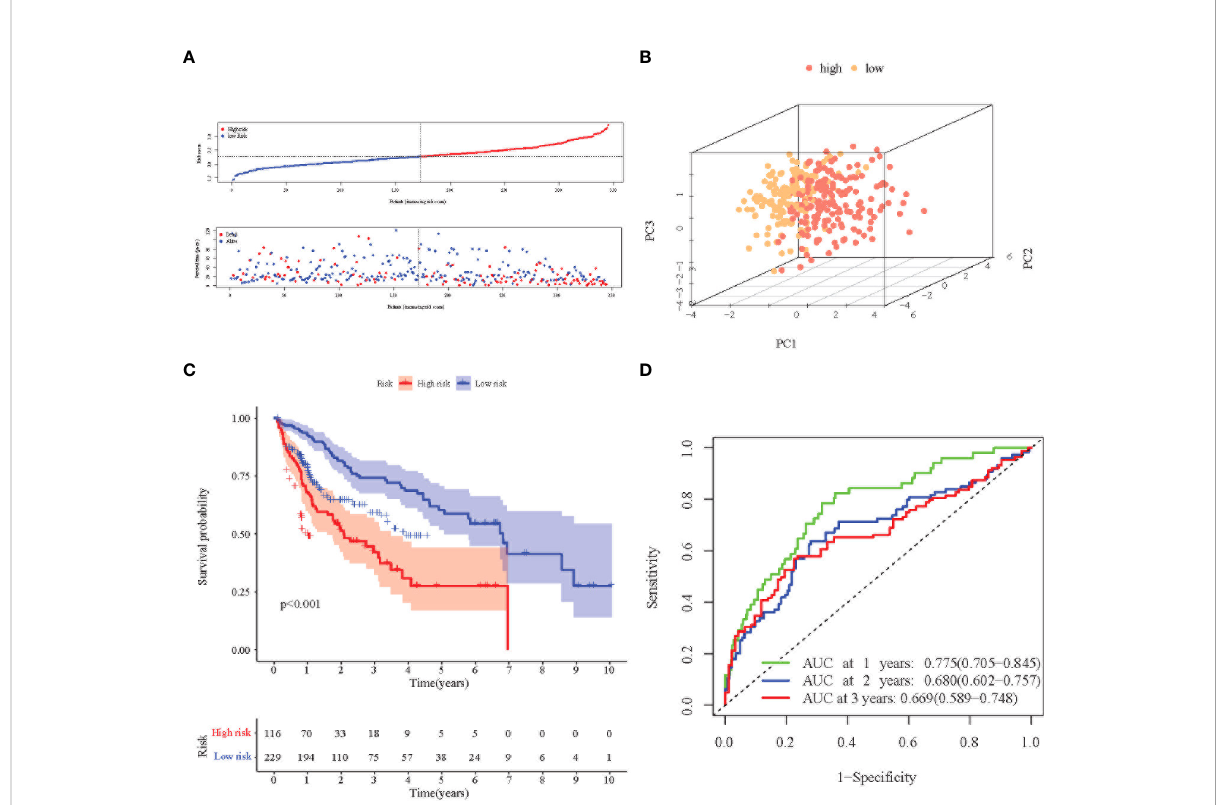
FIGURE 3 Prognostic analysis of the 8-gene signature in the TCGA cohort. (A) Distribution of risk score in high-risk and low-risk groups of the TCGA cohort; and distribution of overall survival in the TCGA cohort in different groups. (B) 3D-PCA analysis of the TCGA cohort. (C) Kaplan – Meier curve of the 8-gene signature in the TCGA cohort (P<0.05). (D) ROC analysis for risk signature at 1, 2, and 3 year survival time in the TCGA